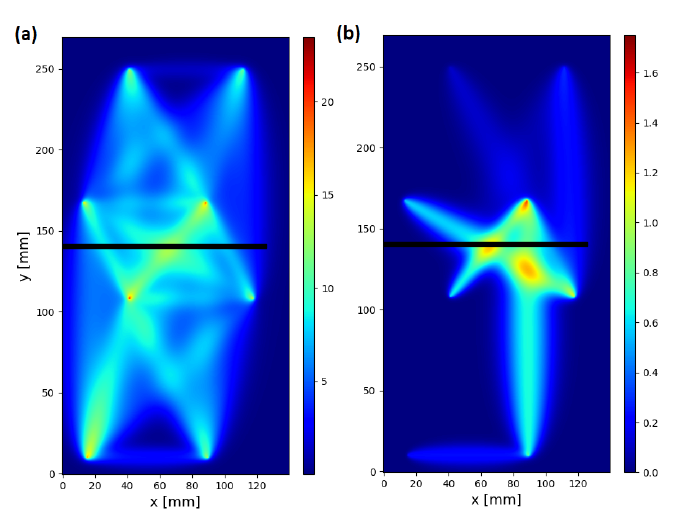
Figure 13. Averaged visualization map of corr damage index for specimen no. 1 above 60 ◦ C with indication of introduced damage: ( a ) uncompensated damage index; ( b ) standard compensation scheme with k =